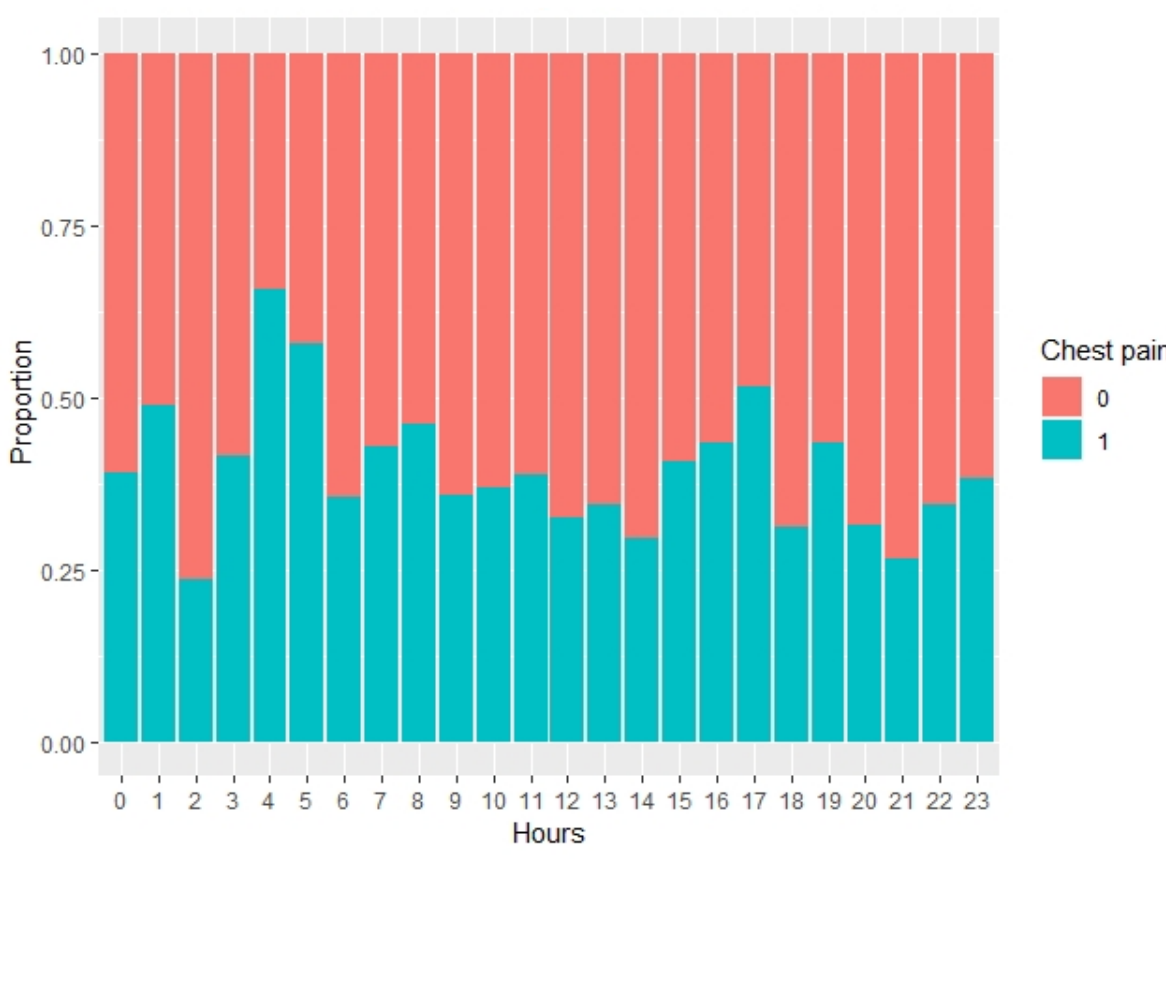
Figure 5. Proportion of patients with chest pain by the